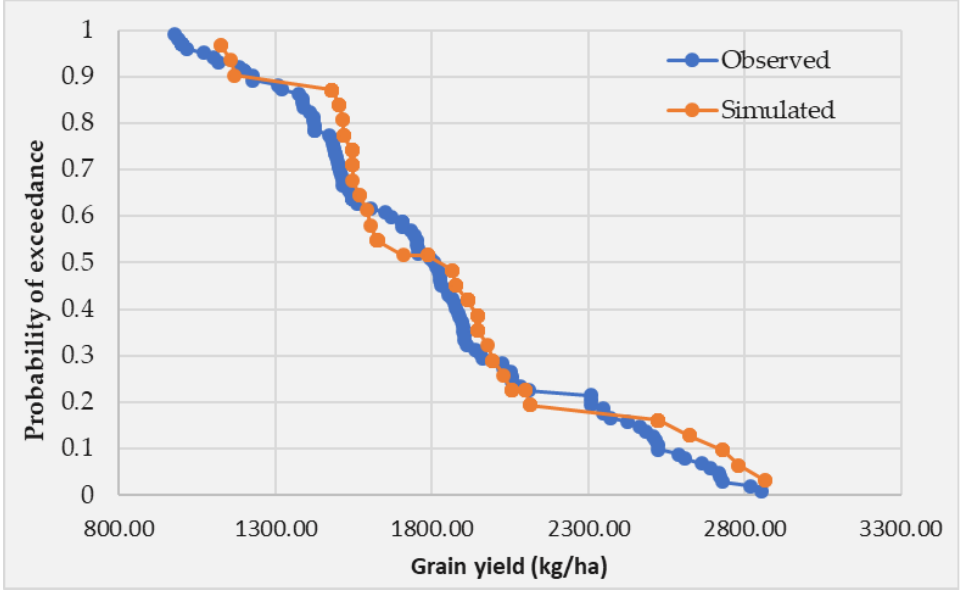
Figure 3. Probability of exceedance for observed and simulated yields for model calibration in Ruzizi Plain. Table 6. Genetic coefficients for the maize variety Ecavel